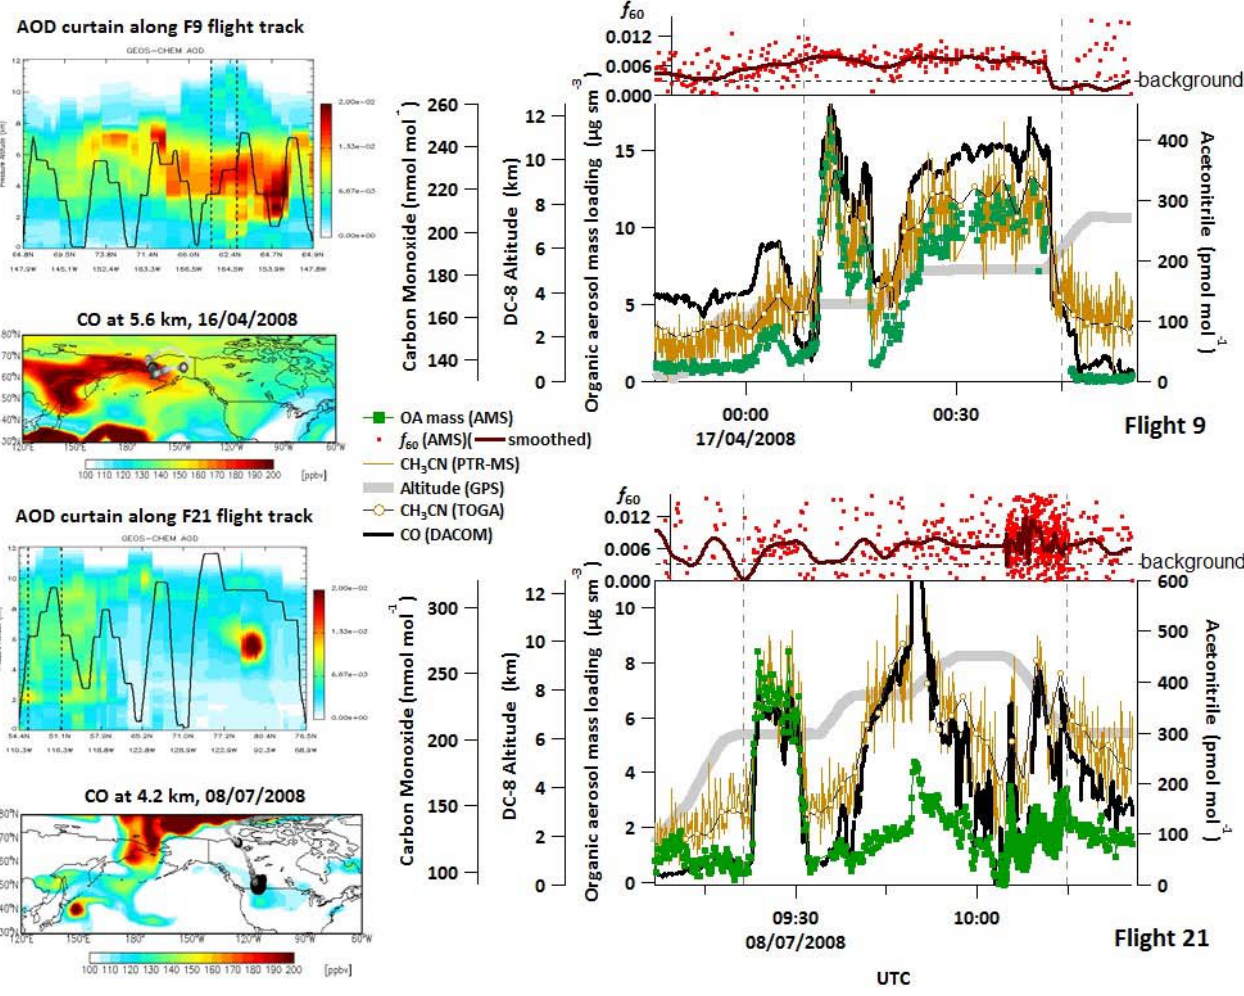
Fig. 2. Two long-range plumes intercepted during flight 9 of ARCTAS-A (top) and flight 21 of ARCTAS-B (bottom). Left panels: GEOS- Chem model output showing the aerosol optical depth curtain along the flight tracks with plume time-frames indicated by dashed lines (top), and global CO at a time and altitude relevant to the plume crossings (bottom). DC-8 flight tracks are also shown on the map, coloured and sized by gas-phase acetonitrile mixing ratio. Right panels: Time-series in-situ data for the plume transects aboard the DC-8 aircraft, showing the increase in gas- and aerosol-phase species associated with the plumes predicted by the model. The plume time-frames are indicated by dashed